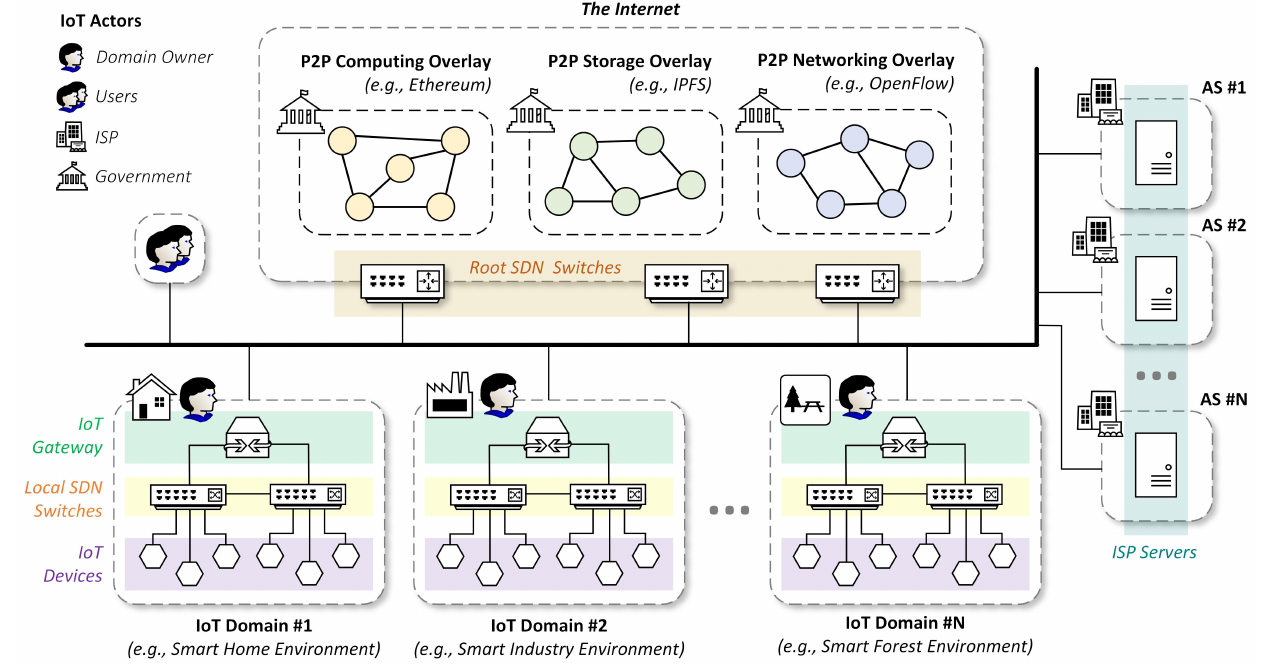
Figure 1. Our conceptual decentralized IoT architecture from a low-level perspective. The government manages three overlay networks, which host shared decentralized services. The domain owners maintain the IoT domains and supply IoT resources to IoT users. Finally, the Internet Service Provider (ISP) provides connectivity to others through their autonomous system